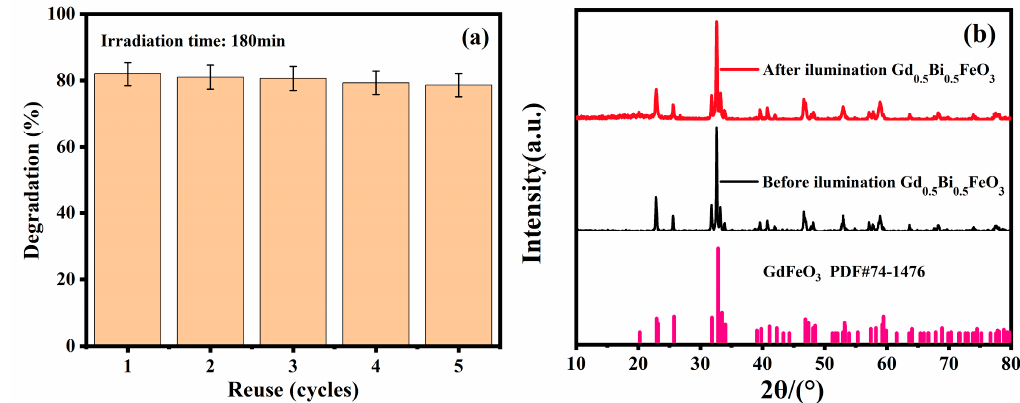
Figure 9. ( a ) Reusability of Gd 0.5 Bi 0.5 FeO 3 nanoparticles in the degradation of MB under UV light irradiation over five cycles; ( b ) XRD patterns of the Gd 0.5 Bi 0.5 FeO 3 sample before and after the photocatalytic